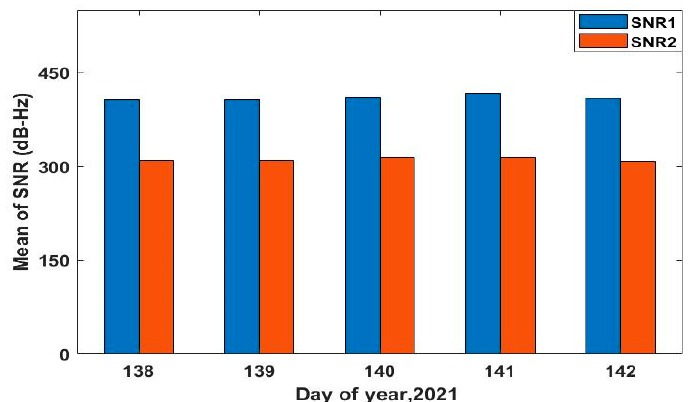
Figure 4. Mean SNR of six COSMIC-2 satellites during DOY138-142, 2021.